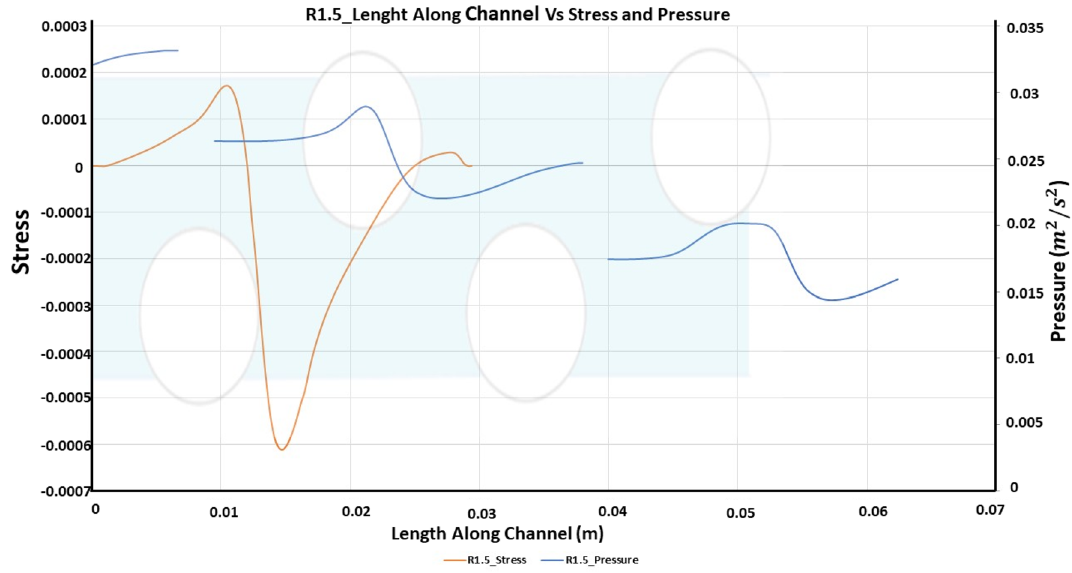
Figure 8. Length along channel vs stress and pressure for R1.5.